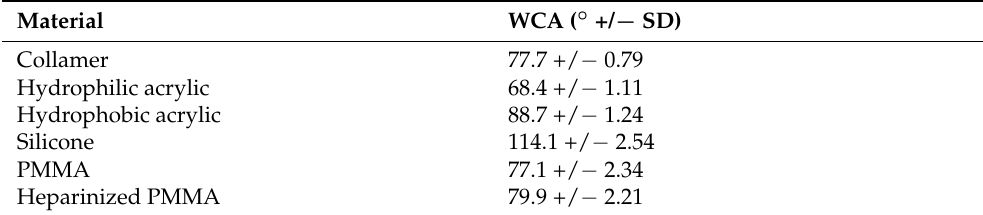
Table 3. Values of the average water contact angles (in ◦ +/ − the standard deviation, SD) on the tested IOLs